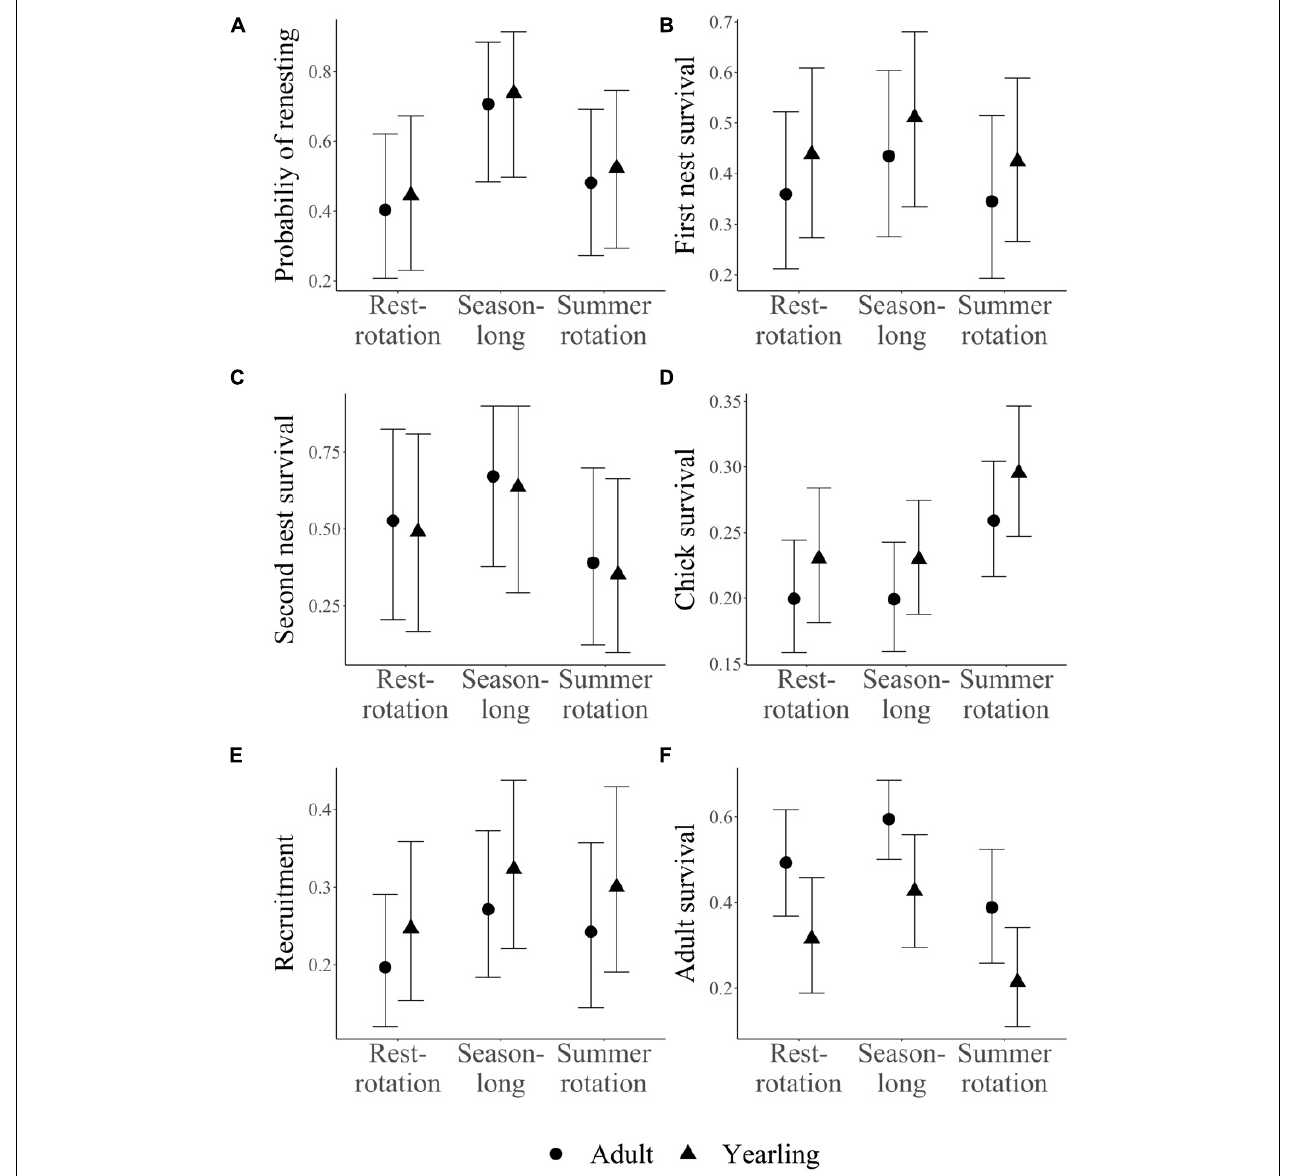
FIGURE 2 | Estimated vital rates ( ± 95% credible intervals) for each grazing system and stage class (yearling and adult) using a female-based integrated population model for sharp-tailed grouse in western Montana. Four vital rates ( A–D ; renesting propensity, first and second nest survival, chick survival) that varied by grazing system and additional parameters which were either assumed to be constant across grazing system (clutch size, egg hatchability) or for which we did not have data to estimate grazing effects (first nest propensity, juvenile survival) were combined to estimate recruitment (E) . Recruitment (E) and adult survival (F) were then used to calculate population growth rates for each grazing